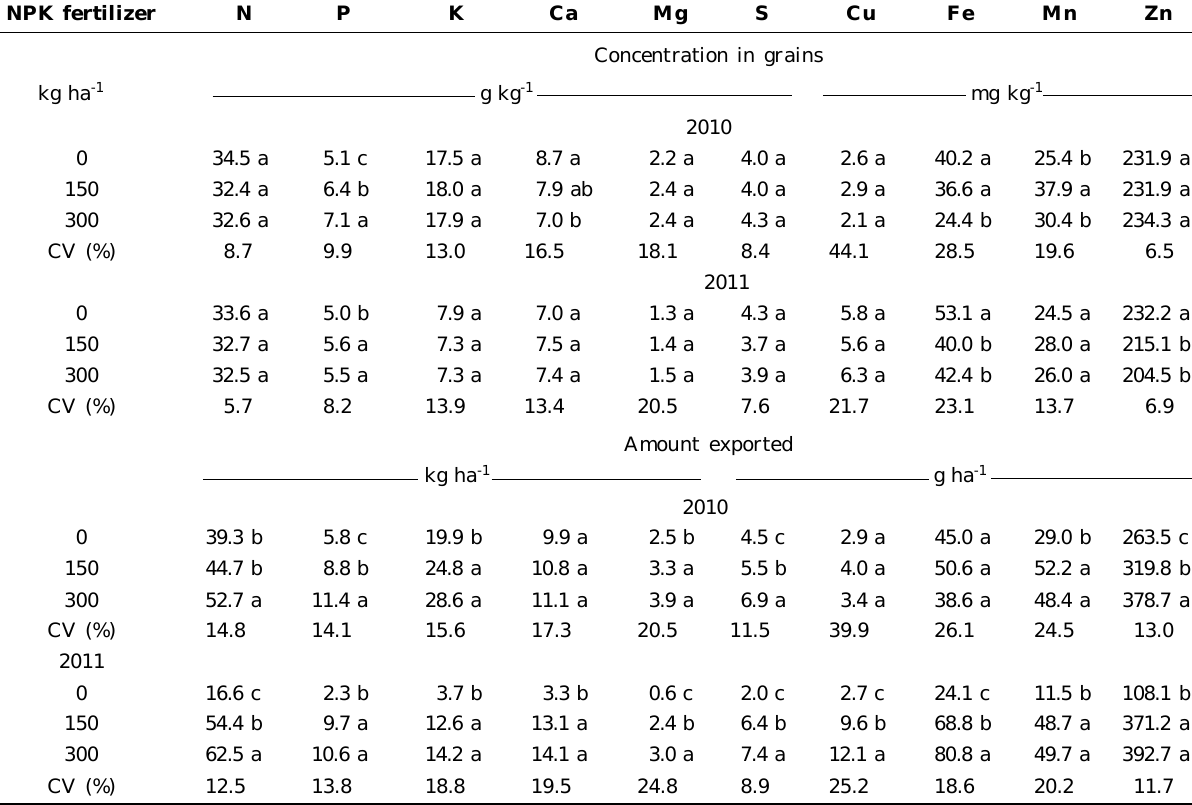
Table 4. Nutrient concentration and exportation in crambe grains treated with different rates of the fertilizer N-P 2 O 5 -K 2 O